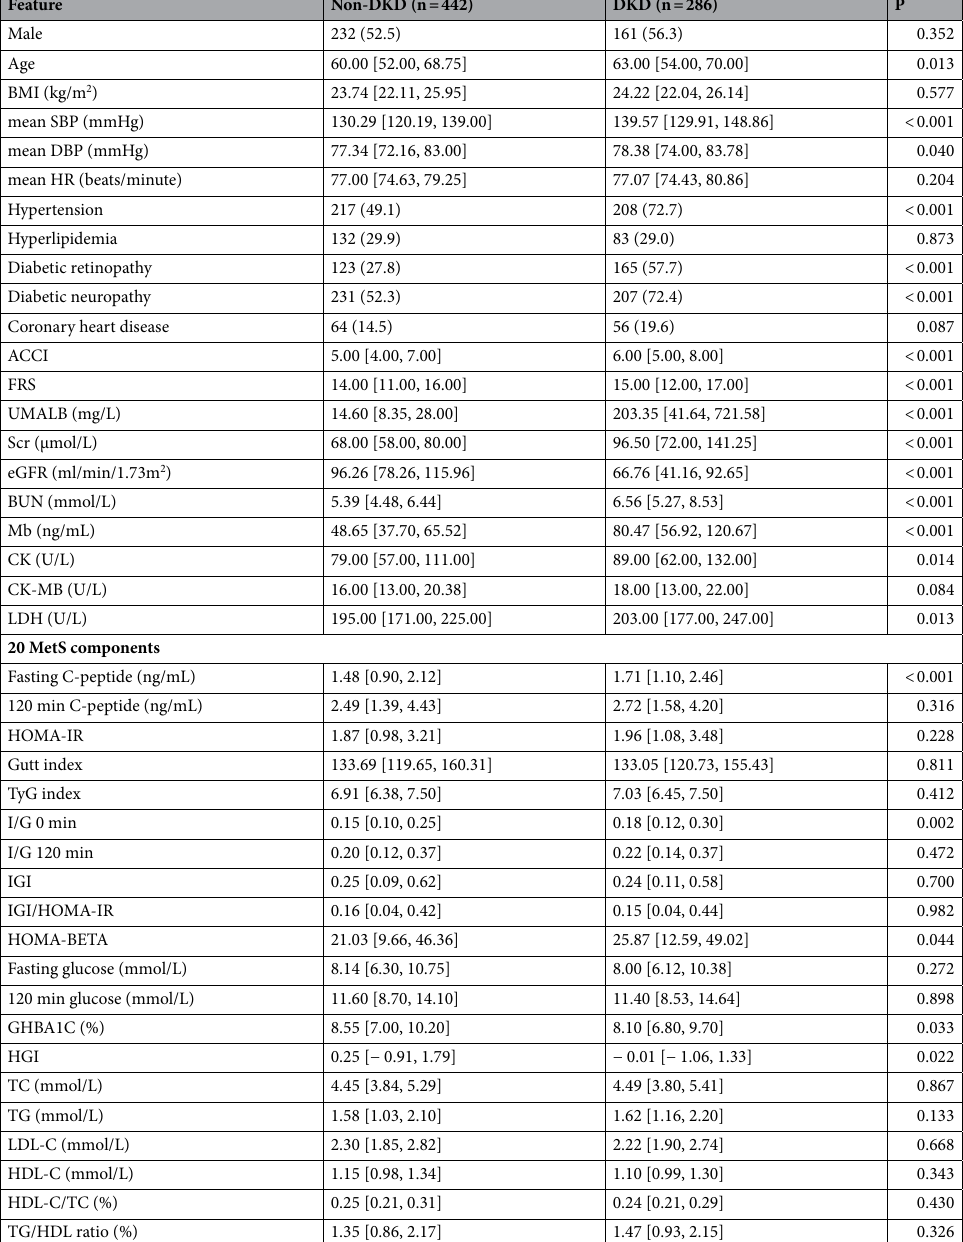
Table 1. Demographic and clinical features. Data are presented as median [interquartile range] for continuous variables or number (%) for categorical variables. P-values for differences between groups were based on the Wilcoxon test for continuous variables and the chi-square test for categorical variables. Details of features calculation are shown in Table S1. Non-DKD Diabetes without any kidney disease, SBP systolic